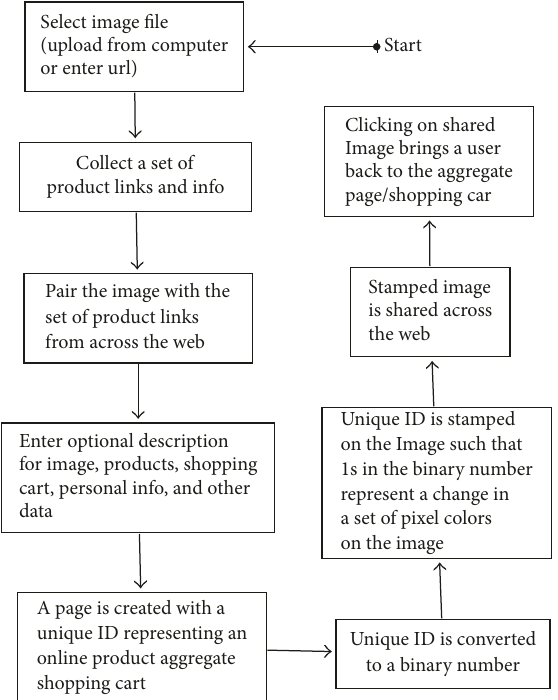
Figure 2: Procedure describing the assembly of product collections and associating them with a “Hook”